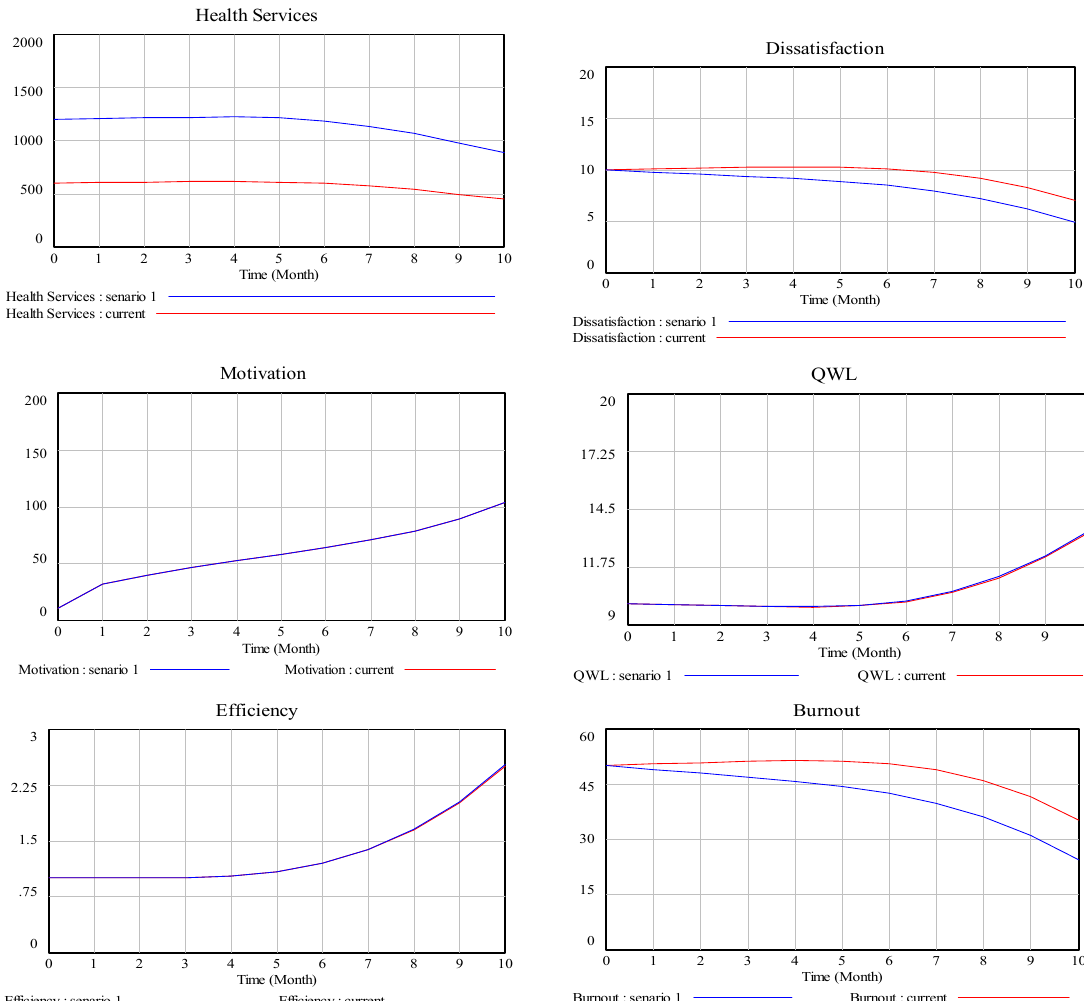
Fig. 5. The Impact of health services improvement on the variables of the system dynamics model